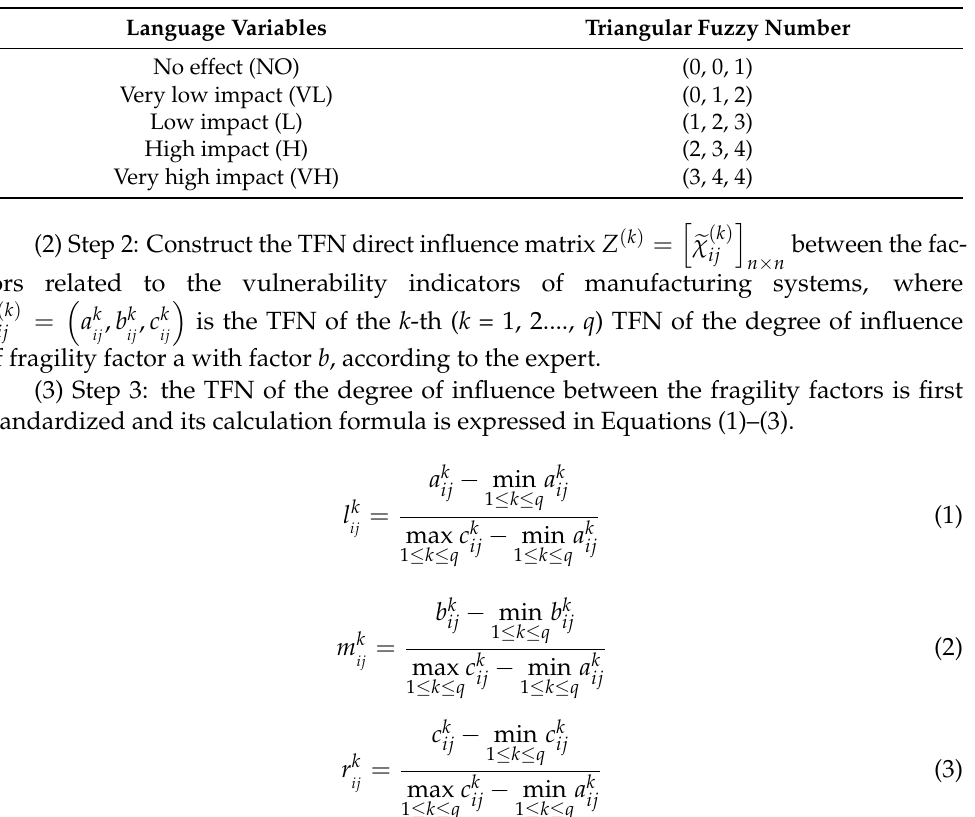
Table 2. Semantic transformation